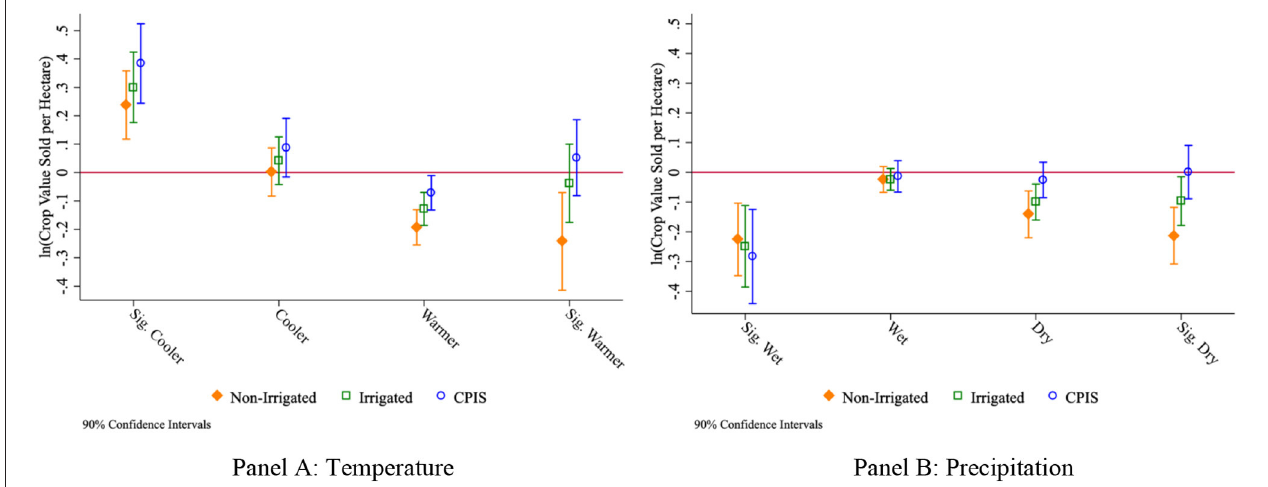
FIGURE 5 | Effect of irrigation on crop revenue resilience. Coefficient estimates of equation SI.1 from the SI Appendix. The dependent variable is the natural log of crop value sold per county hectare from the 1950, 1954, 1959, 1964, 1969, 1974, 1978, 1982, 1987, 1992, 1997, 2002, 2007, 2012, and 2017 Agricultural Censuses. The estimates represent deviations from a county’s average relative to normal levels of temperature (A) and precipitation (B) . Irrigated and CPIS shares are the fractions of the county irrigated or with CPIS available, respectively, as of 2007. The effect shown is for a one standard deviation increase of irrigated share (0.15). Because “Irrigation” and “CPIS” are not nested, the coefficients come from separate estimations. Year and county fixed effects are included as well as a third-order polynomial of temperature. The sample are the arid counties (west of the 98th meridian) from the “Ogallala counties” (within 100km of the aquifer